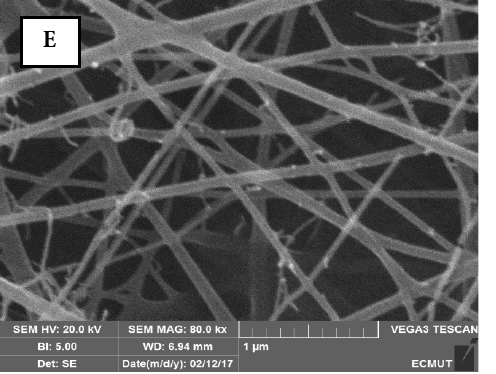
Fig. 7. SEM images of (A) CS/PEO nanofiber without additive, (B) CS/PEO nanofiber containing H 2% w/v, (C) H 1% w/v, (D) AV 1% w/v, (E) H/AV 1% w/v Fig. 8, represent SEM images of fibroblast cells cultured on nanofiber containing films. The wide fibroblast cells appeared among the fibers are notable in the images. Clearly, the fibroblasts are grown on nanofiber containing films with acceptable physical appearance.